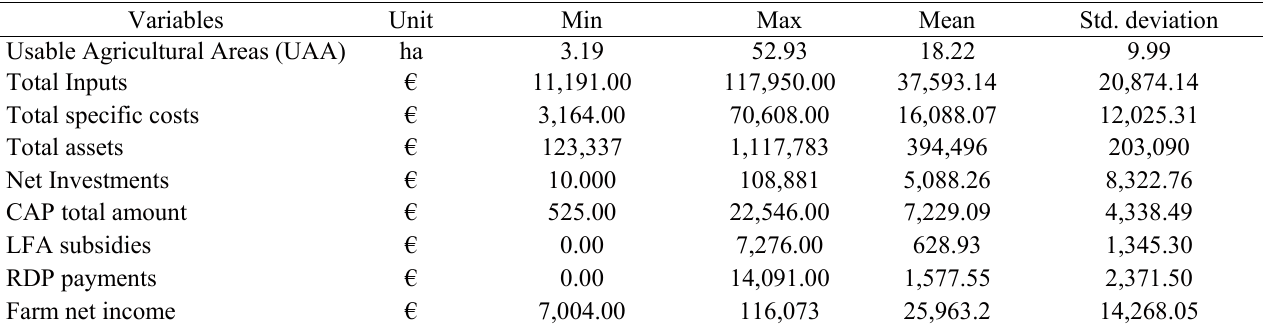
Descriptive statistics in all Italian farms part of FADN dataset over the years 2004–2016